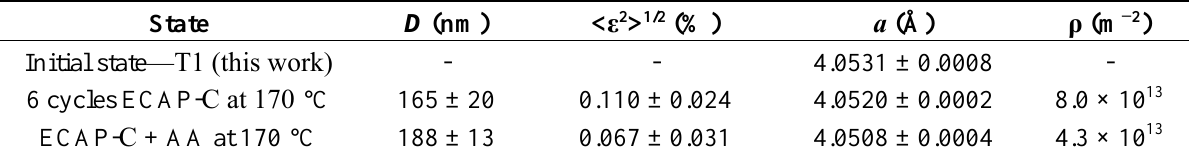
Table 1. Results of the X-Ray diffraction analysis of the Al 6101 alloy in the initial state (T1), after ECAP-C and ECAP-C +